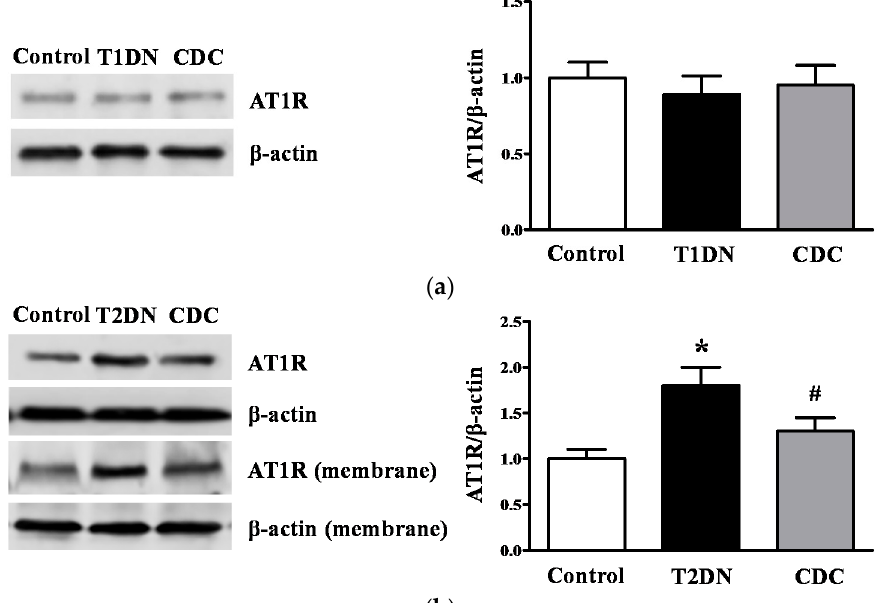
Figure 7. Cont. Figure 7. Cont